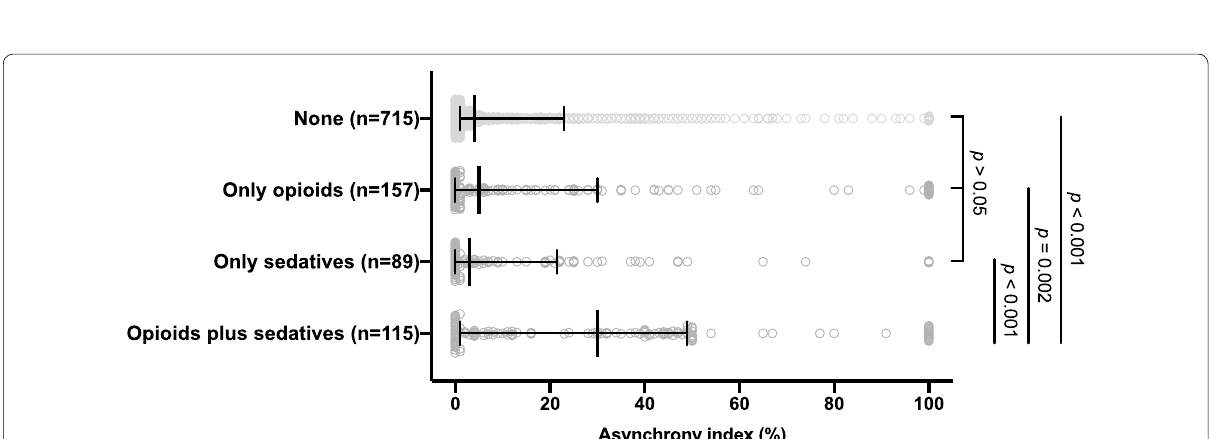
Fig. 6 A significant difference in the asynchrony index was found among different analgesia/sedation strategies ( p < 0.001). Individual data, median, and interquartile ranges are shown. Asynchrony index during combined administration of opioids and sedatives was significantly higher than those during single use of opioids or sedatives, as well as no use of these two types of drugs. No significant difference was found in asynchrony